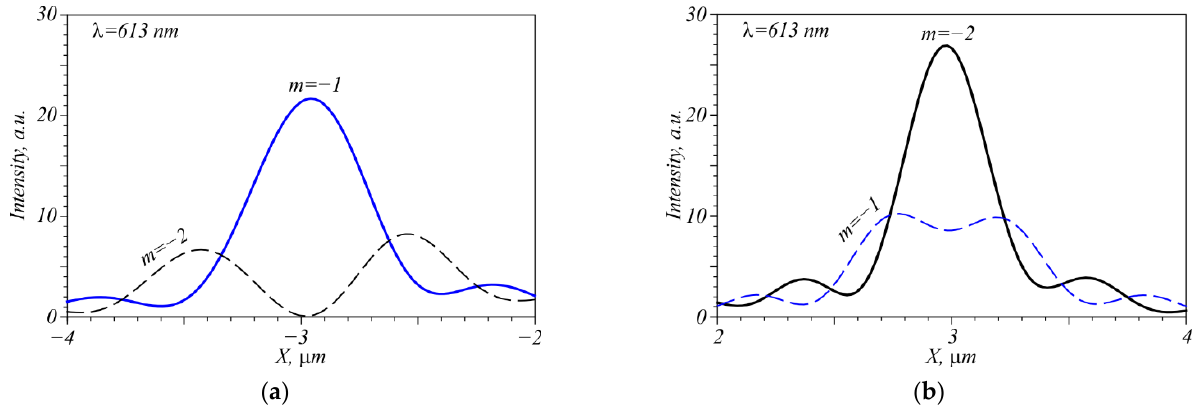
Figure 6. Intensity profiles through centers of the focal spots in the presence of two vortices with one wavelength λ = 613 nm and two TCs m = − 1 and m = − 2: − 4 < x < − 2 ( a ), 2 < x < 4 ( b ).